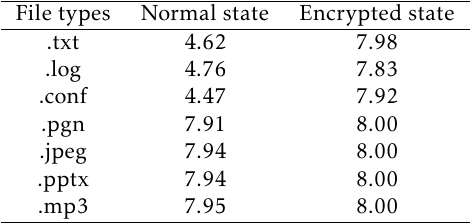
Table 2. File entropy of different files in normal state and encrypted